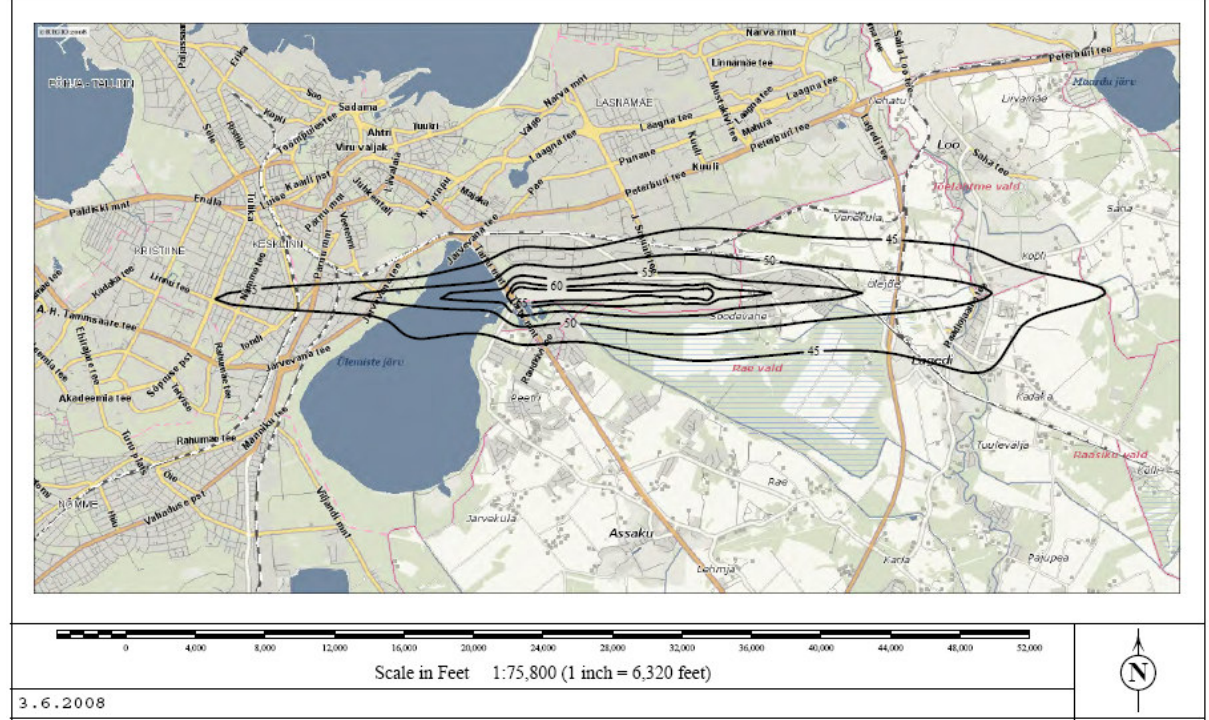
Fig 5. Tallinn Airport. Noise map according to Directive 2002/49/EC. Lnight (23-07) noise contours. 2006 average traffic